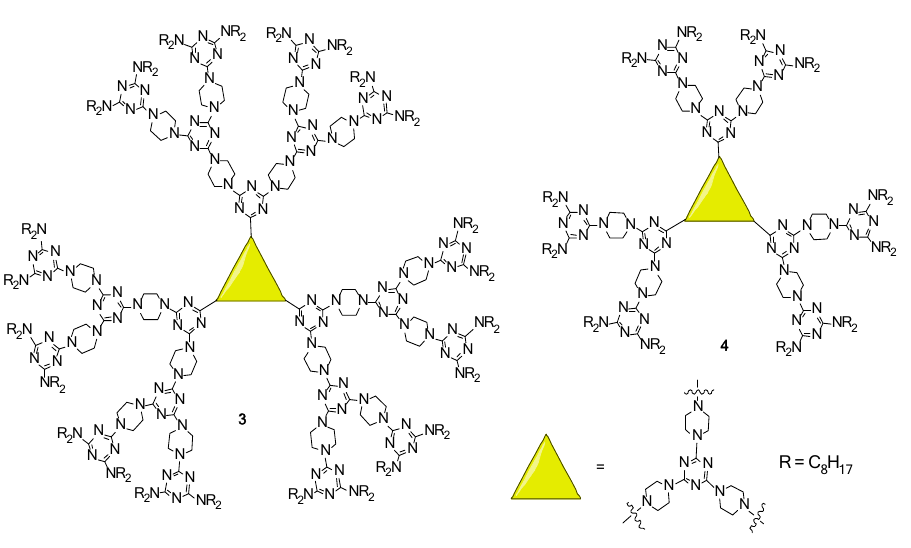
Figure 2. Structures of dendrimers ( 3 ) and ( 4 ) with C 3 -symmetry.